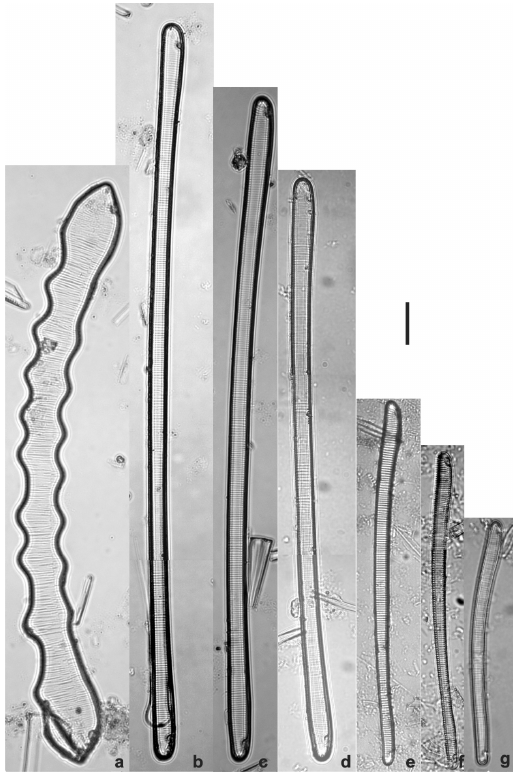
Figure 6a-g. General view of Actinella spp. valves under LM. 6a. A. mirabilis . 6b-d. A. rionegrensis . 6e-g. A. robusta (scale bar: 20